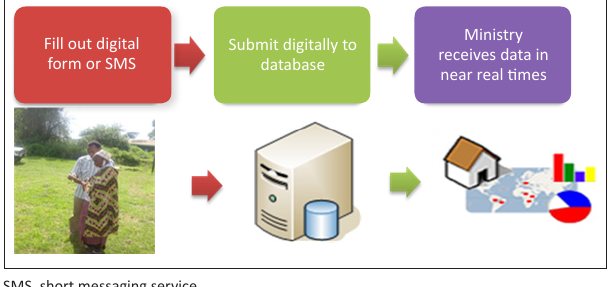
Fill out digital form or SMS